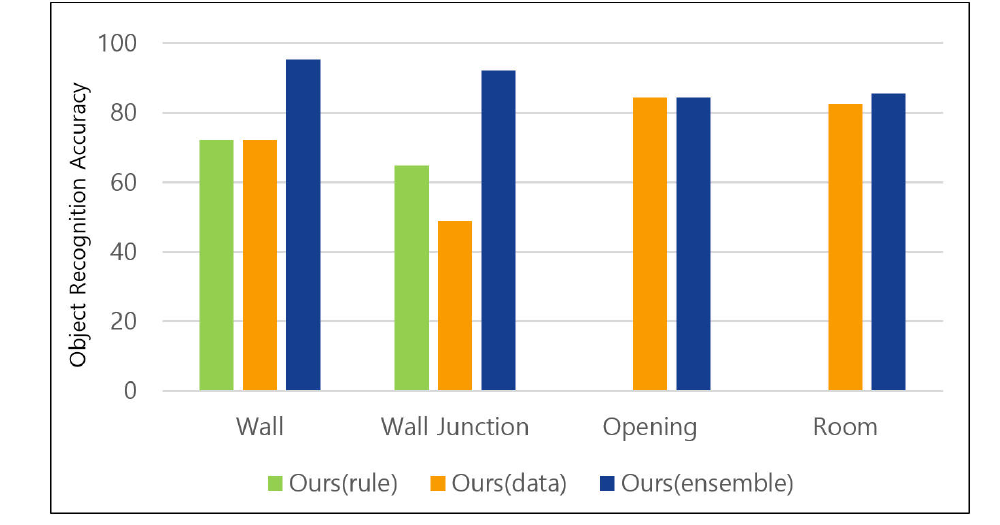
Figure 10. Object recognition accuracy of each